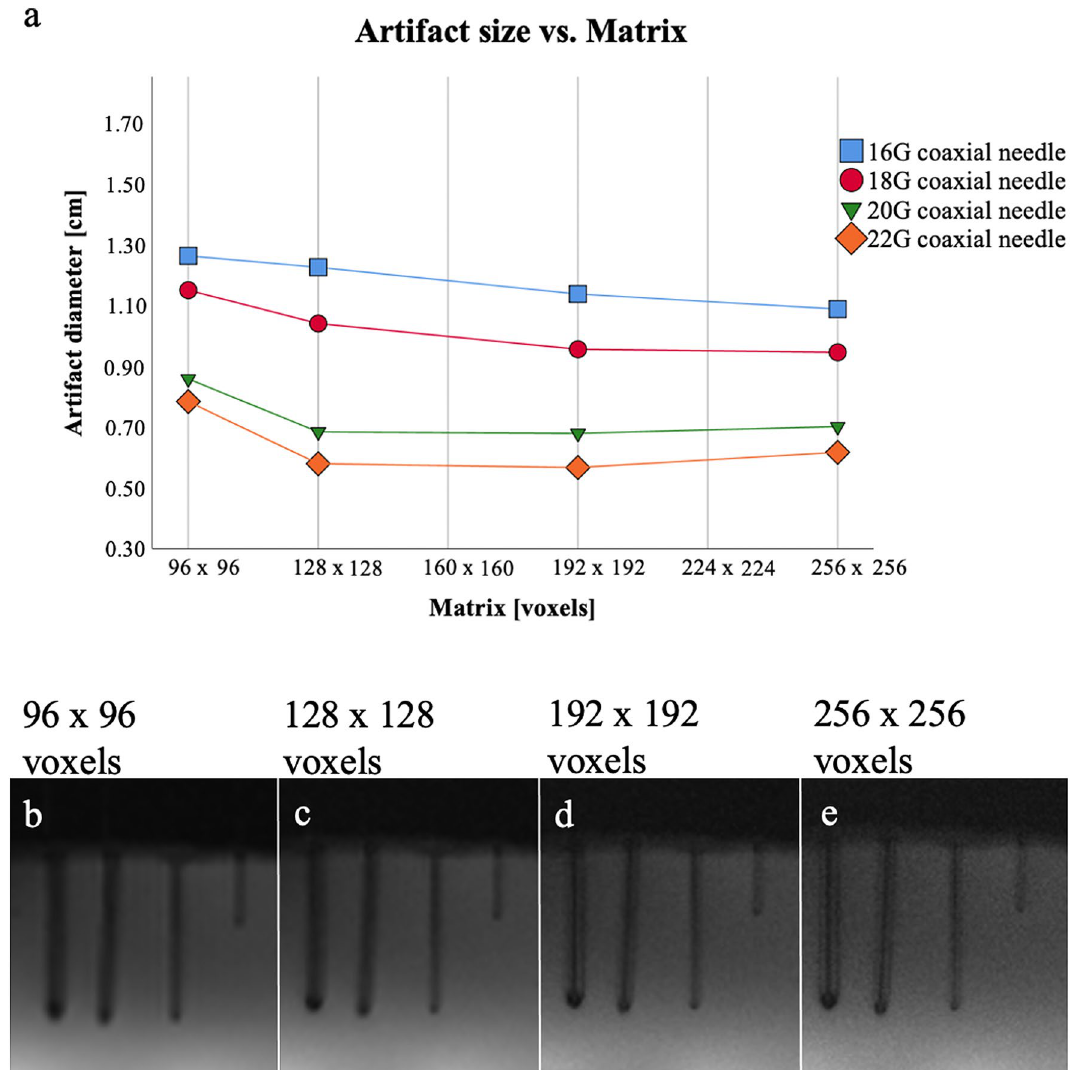
Figure 3. Scan series 3. Mean values (of both readers) of the measured artifact diameters ( a ) of the 16G, 18G, 20G, 22G needles with different matrix sizes of the T1-weighted GRE sequence. There was a negative correlation ( p < 0.005) of artifact diameter with matrix for 16G ( r = − 0.993) needles, but no significant correlation for 18G ( r = − 0.905), 20G ( r = − 0.611), and 22G ( r = − 0.549) needles. In ( b – e ) the visual correlate is shown. Note the increasing differentiation between actual needle and artifact at larger matrices. G =